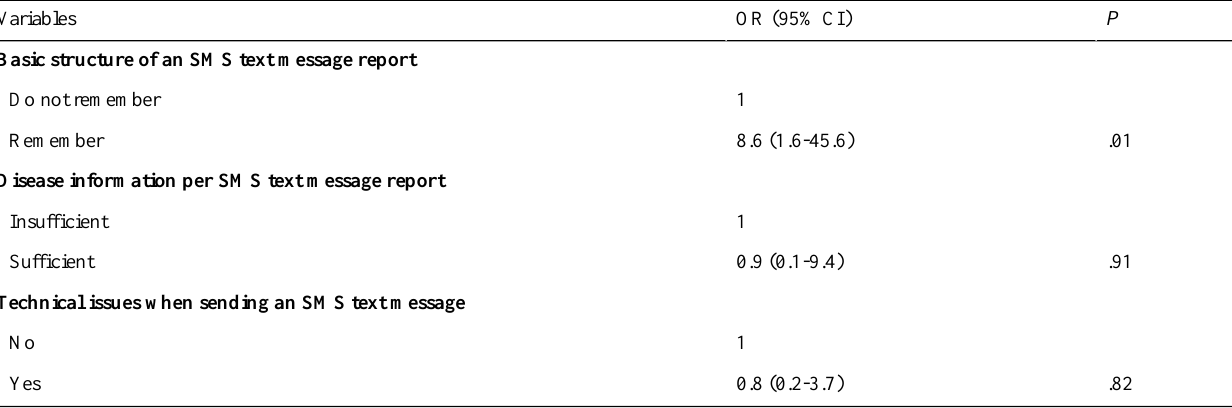
Table 6. Multivariate logistic regression model on the possibility of reporting all 28 diseases asked for by the